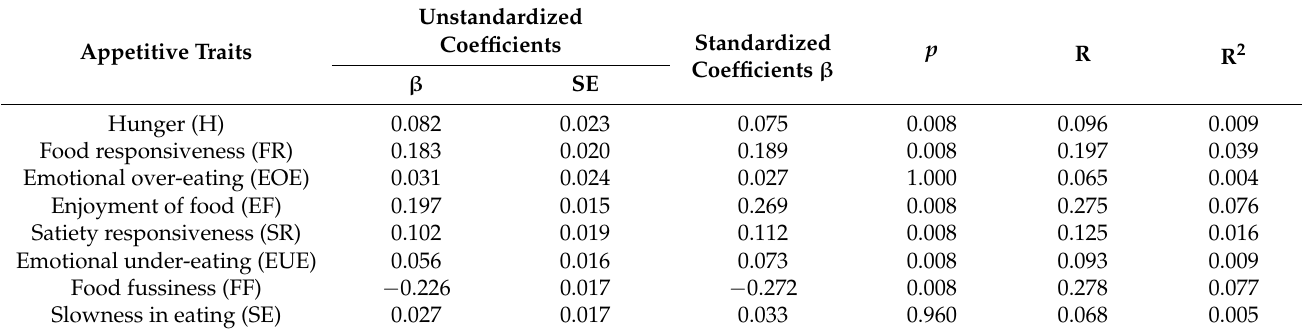
Table 6. Analysis of association between appetitive traits and fruit preference assessed by Food Preference Questionnaire (FPQ) (model adjusted for sex and age) within the population of the second phase of the Polish Adolescents’ COVID-19 Experience (PLACE-19) Study ( n =